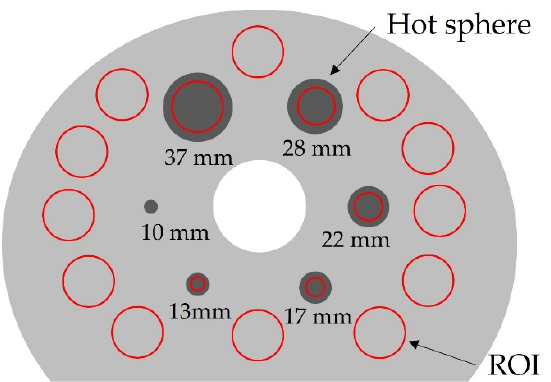
Figure 1. Circular region of interest setting for each hot sphere and background region in the NEMA IEC body phantom. IEC body